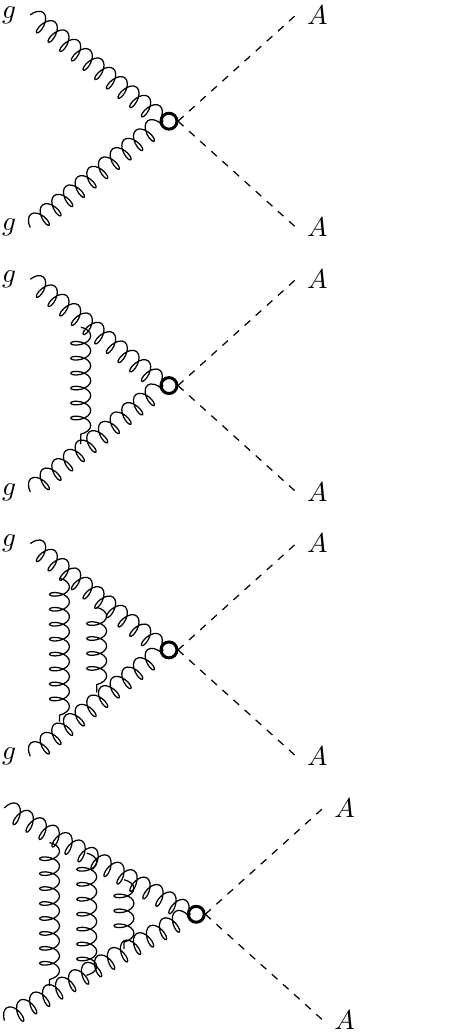
Figure 1 . Type-Ia (left panel) corresponds to the AAgg e(cid:11)ective vertex (denoted by circle) which are form factor up to 3-loop and the right panel (Type-Ib) is related to the e(cid:11)ective vertex Agg (denoted by shaded circle) form factor to 3-loop